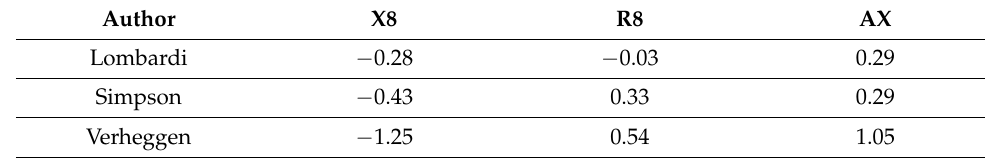
Table 3. Comparison of average z-scores between preterm